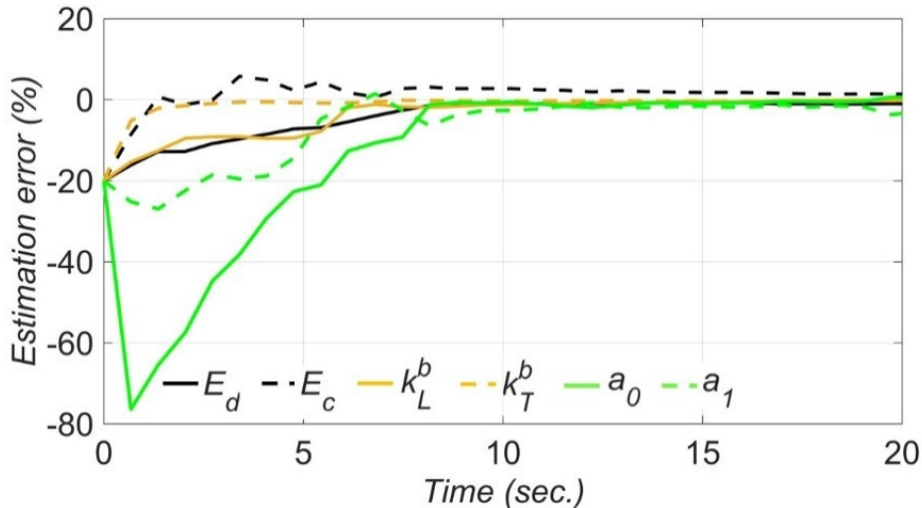
Figure 9. Estimation error time histories for the unknown model parameters through the model updating technique using numerically simulated data.